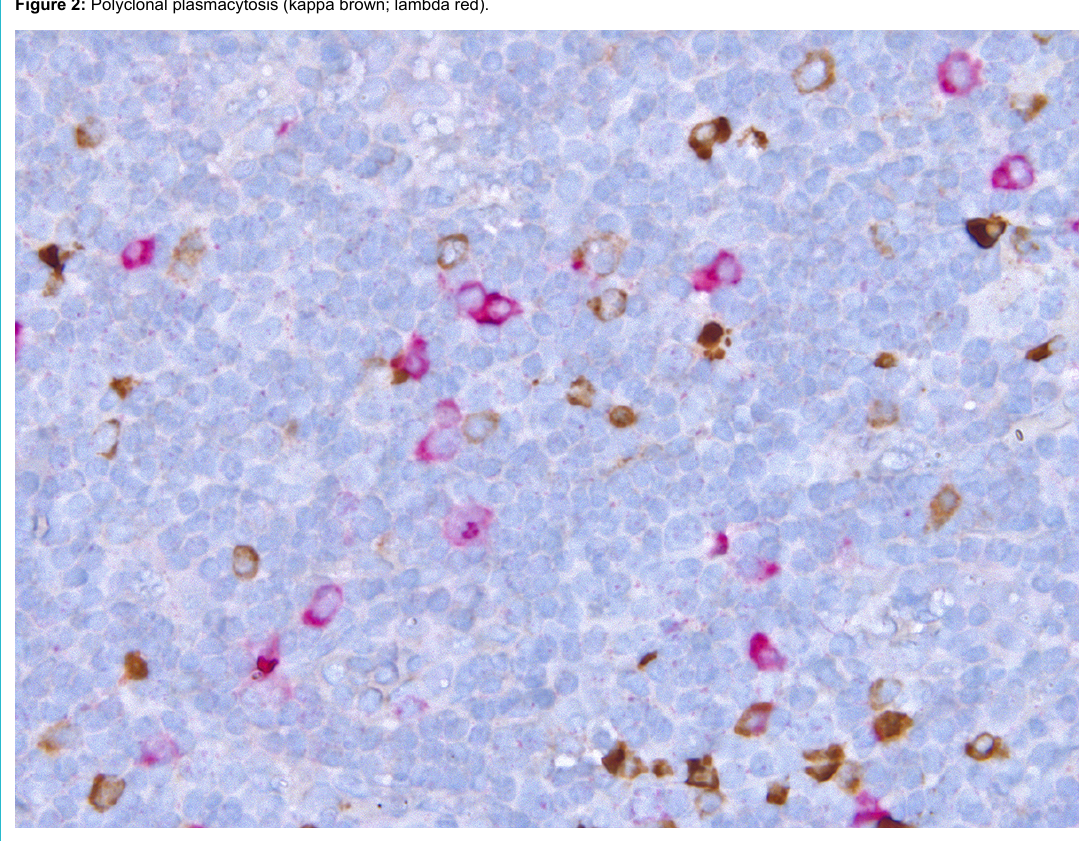
Figure 2: Polyclonal plasmacytosis (kappa brown; lambda red).